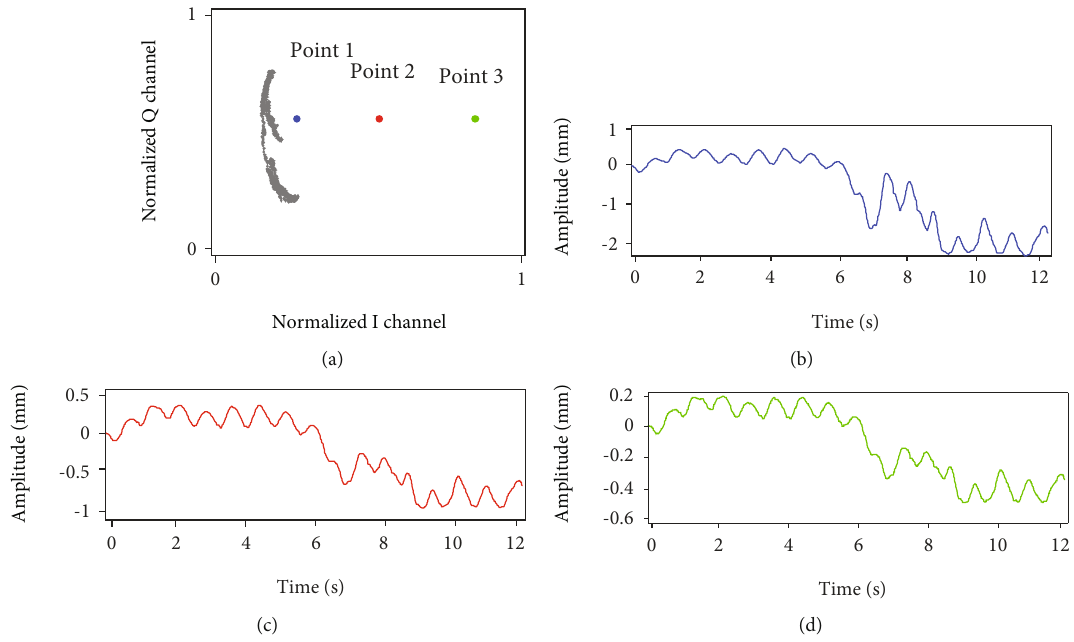
Figure 10: (a) I / Q constellation and the 3 points chosen as DC o ff set for demodulation. (b) Demodulation result when the DC o ff set is at point 1. (c) Demodulation result when the DC o ff set is at point 2. (d) Demodulation result when the DC o ff set is at point 3.